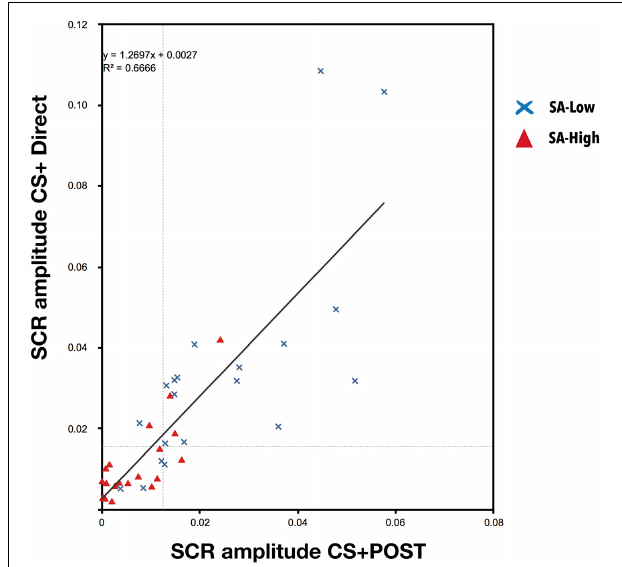
FIGURE 4 | Linear regression between the skin conductance responses to CS + during the vicarious phase (post-conditioned stage, POST) and the skin conductance responses to CS + during the direct phase [ r 2 = 0.67, F ( 1 , 38 ) = 77.304; p < 0.001]. A high predictive capacity of the vicarious conditioning on the conditioned response was observed during the direct phase, together with a greater response during the direct phase because the US becomes the anticipation of a possible aversive contingency [ β = 1.27; t ( 38 ) = 8.792; p < 0.001]. This reinforces the idea of learning